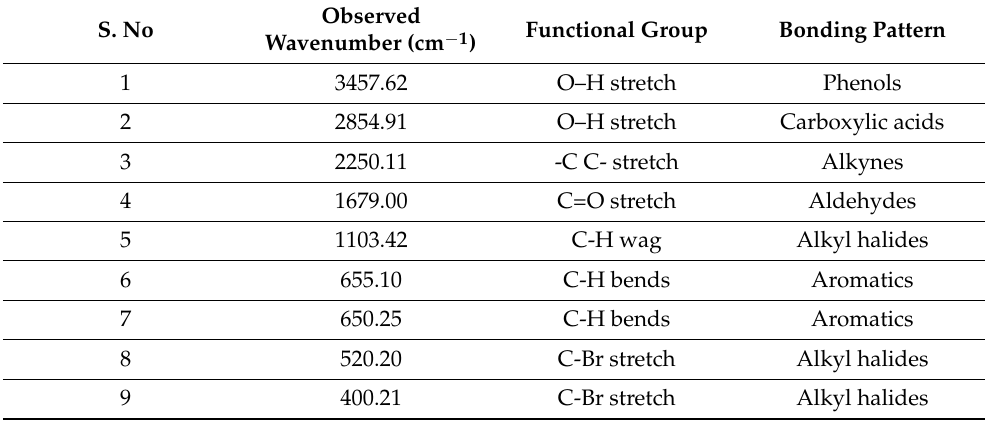
Figure 5. The major functional group was identified from M. anisopliae secondary metabolites using FT-IR analysis. Table 6. The major functional group was identified from M. anisopliae ethyl acetate crude extract using FT-IR